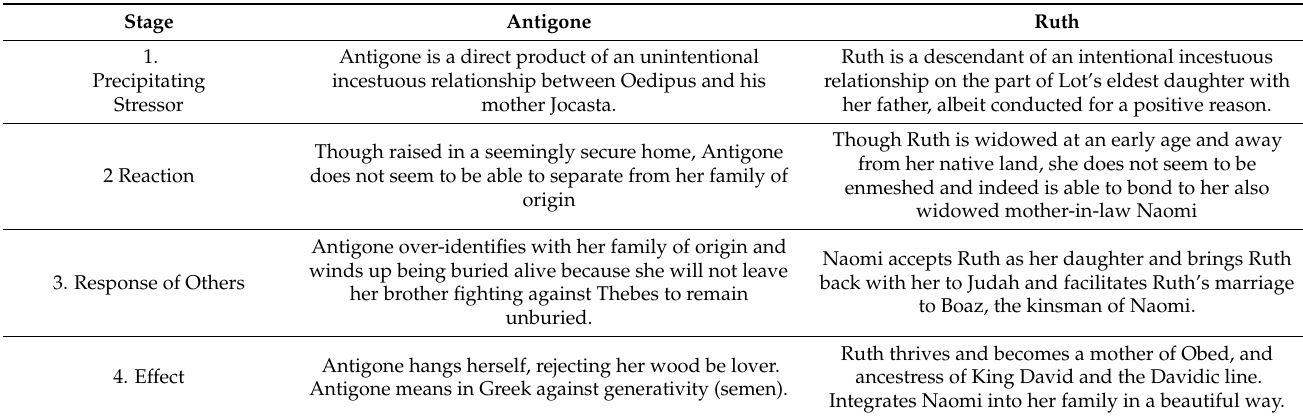
Table 10. Ruth against